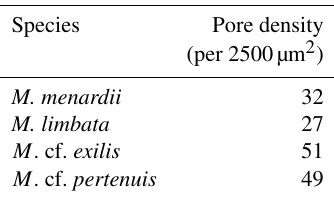
Table 1. The number of pores per 2500µm 2 in the penultimate chamber of select species of Menardella